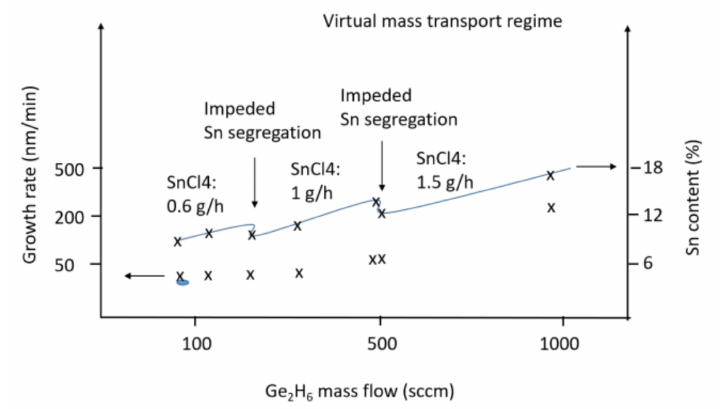
Figure 3. Growth parameters of GeSn deposition and its related Sn